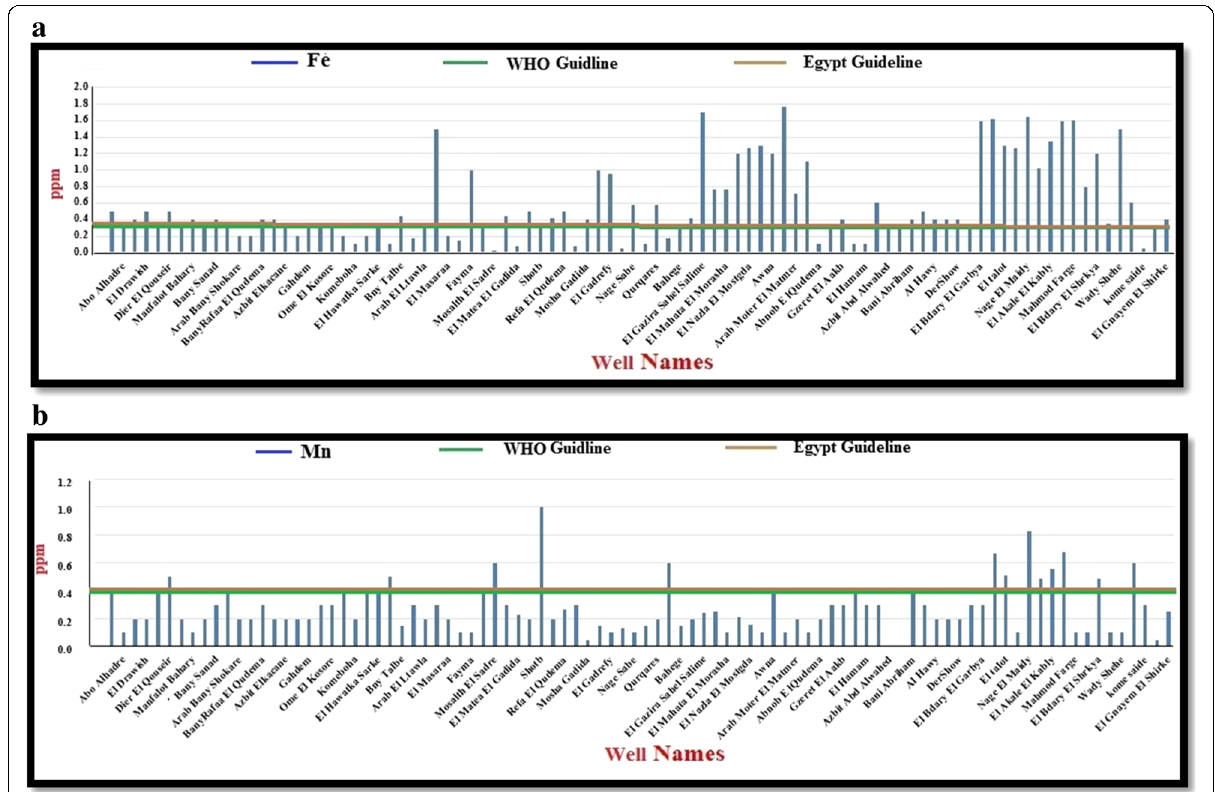
Fig. 13 a Fe and b Mn concentration of groundwater samples compared with WHO Guidelines (2004) and Egyptian Higher Committee for Water (2007) guidelines for drinking